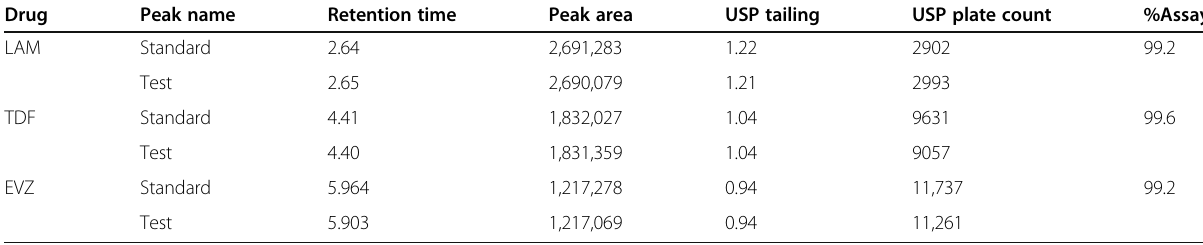
Table 8 Results of % assay of the tablet dosage